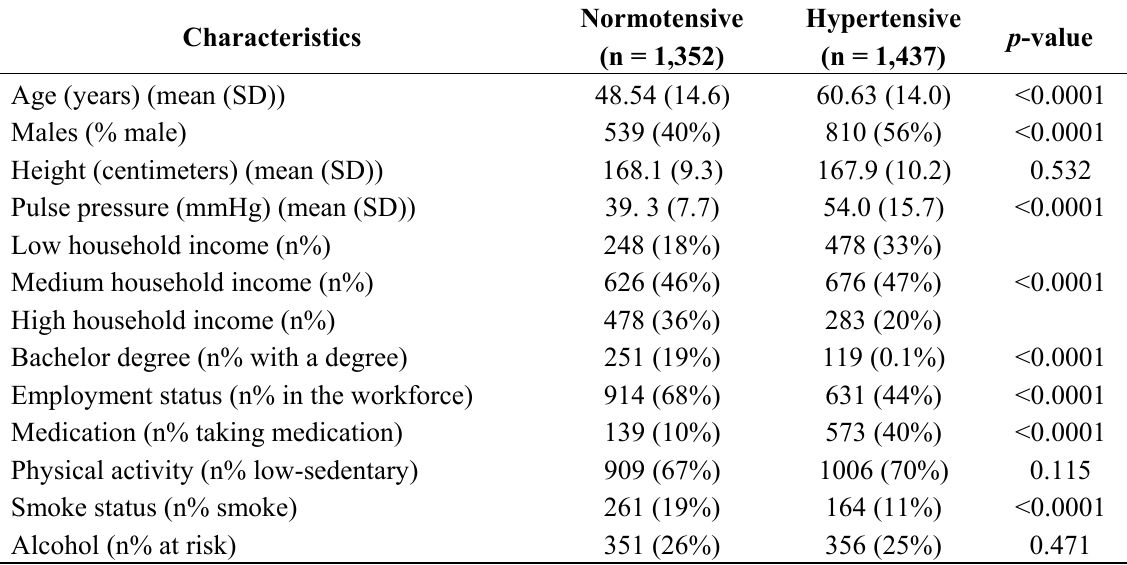
Table 1. Sample characteristics (n =